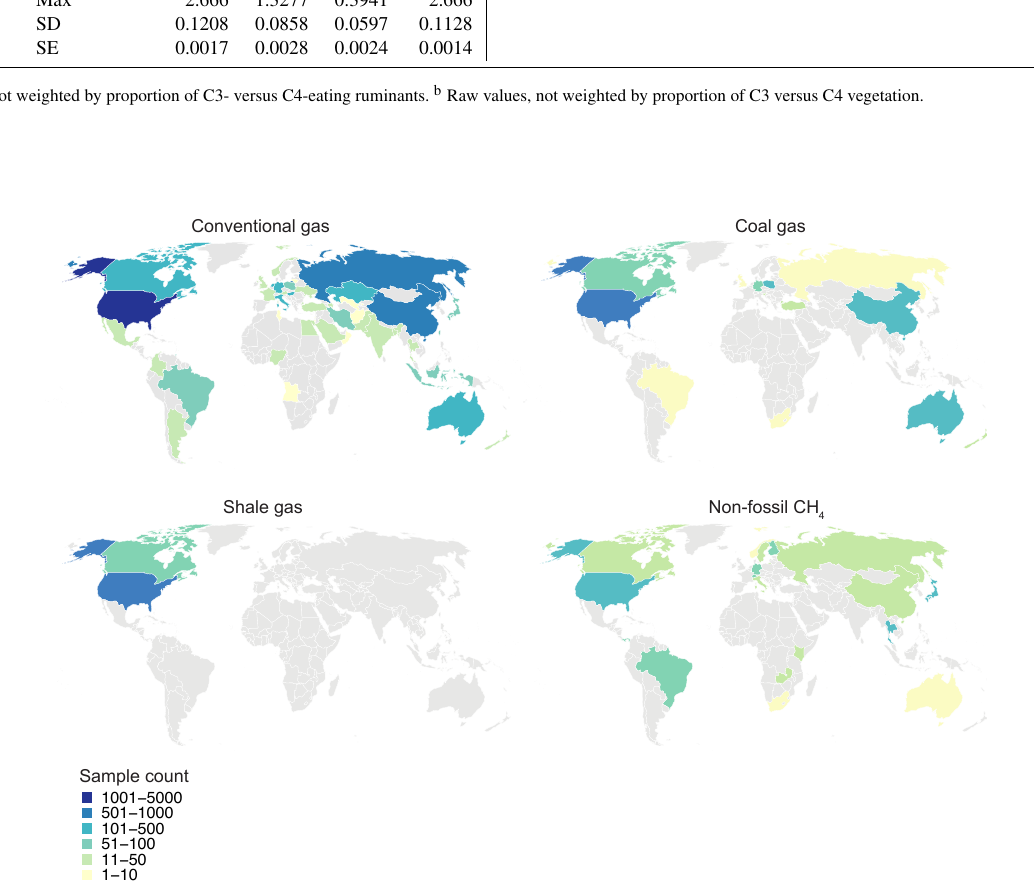
Figure 1. Global maps of country-specific sample counts for conventional gas, coal gas, shale gas, and non-fossil